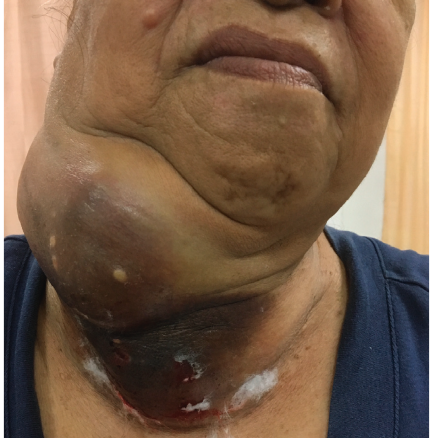
Figure 6: Neglected thyroid cancer.